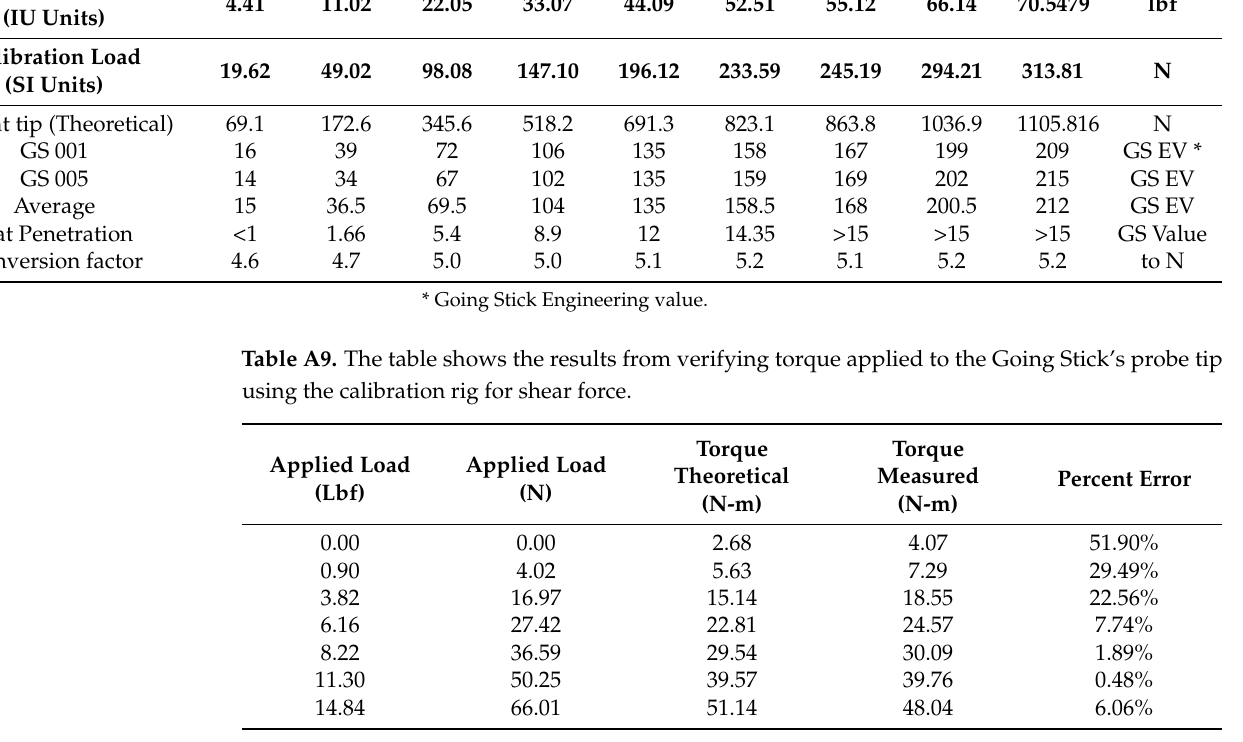
Load at tip (Theoretical)